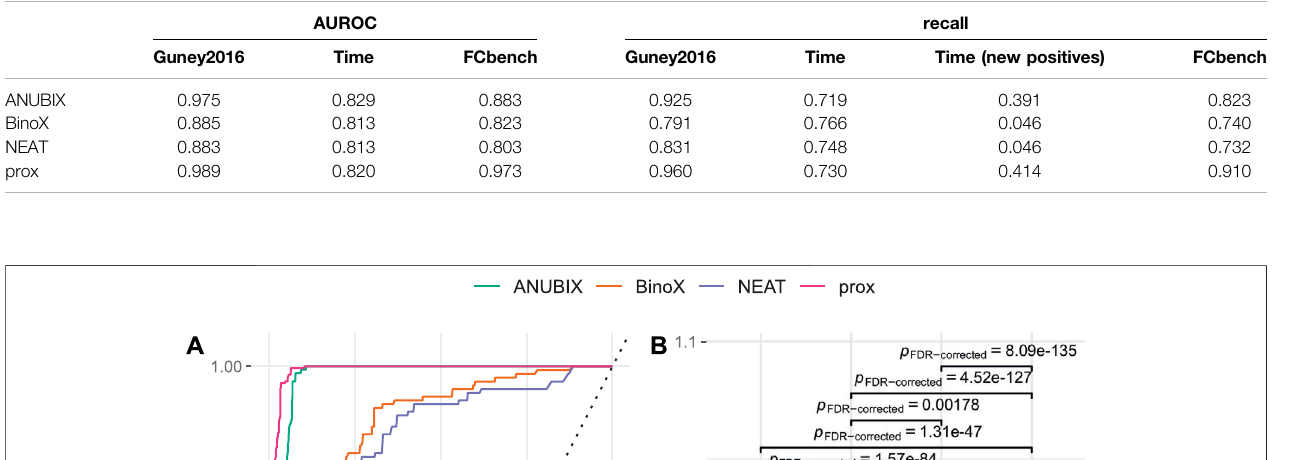
Frontiers in Genetics |